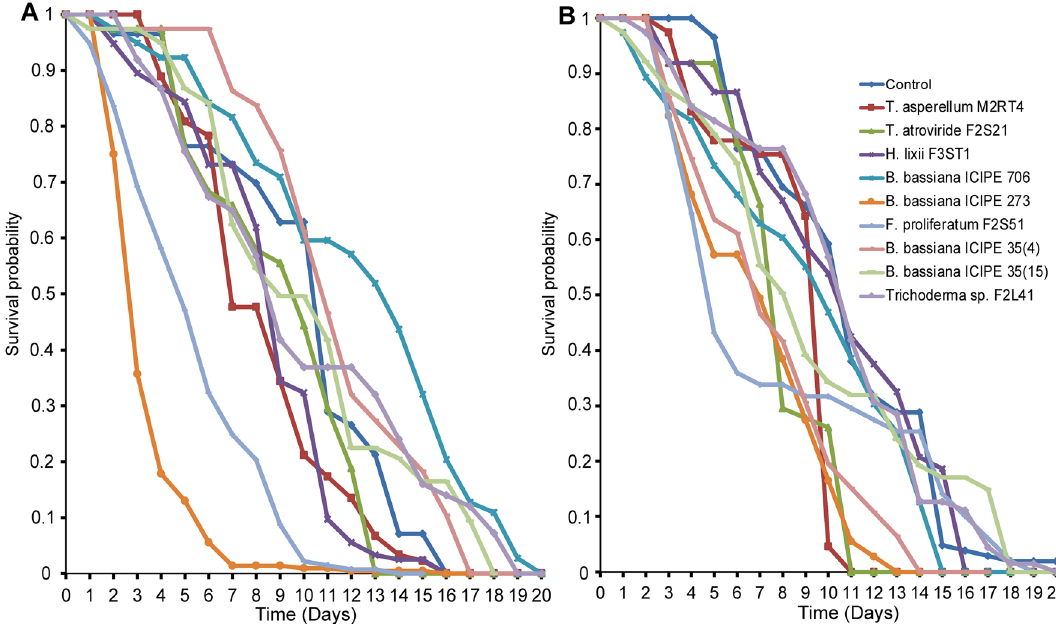
Figure 2. Effect of endophytically-colonized host plants by fungal isolates on survival of adult Tuta absoluta : ( A ) Kaplan–Meier survival curves of Tuta absoluta adults exposed to endophytically-colonized tomato plants, ( B ) Kaplan–Meier survival curves of Tuta absoluta adults exposed to endophytically-colonized nightshade plants ( P < 0.05, n =